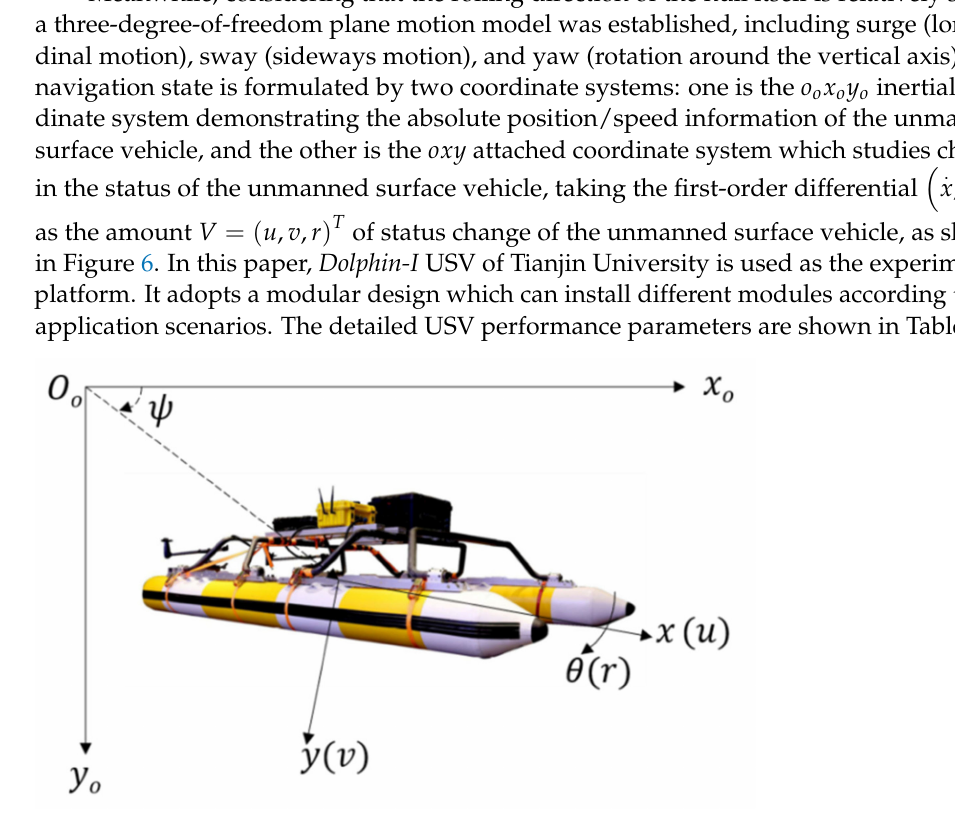
Figure 6. Schematic diagram of USV of three degrees of freedom. Table 2. USV performance parameter setting